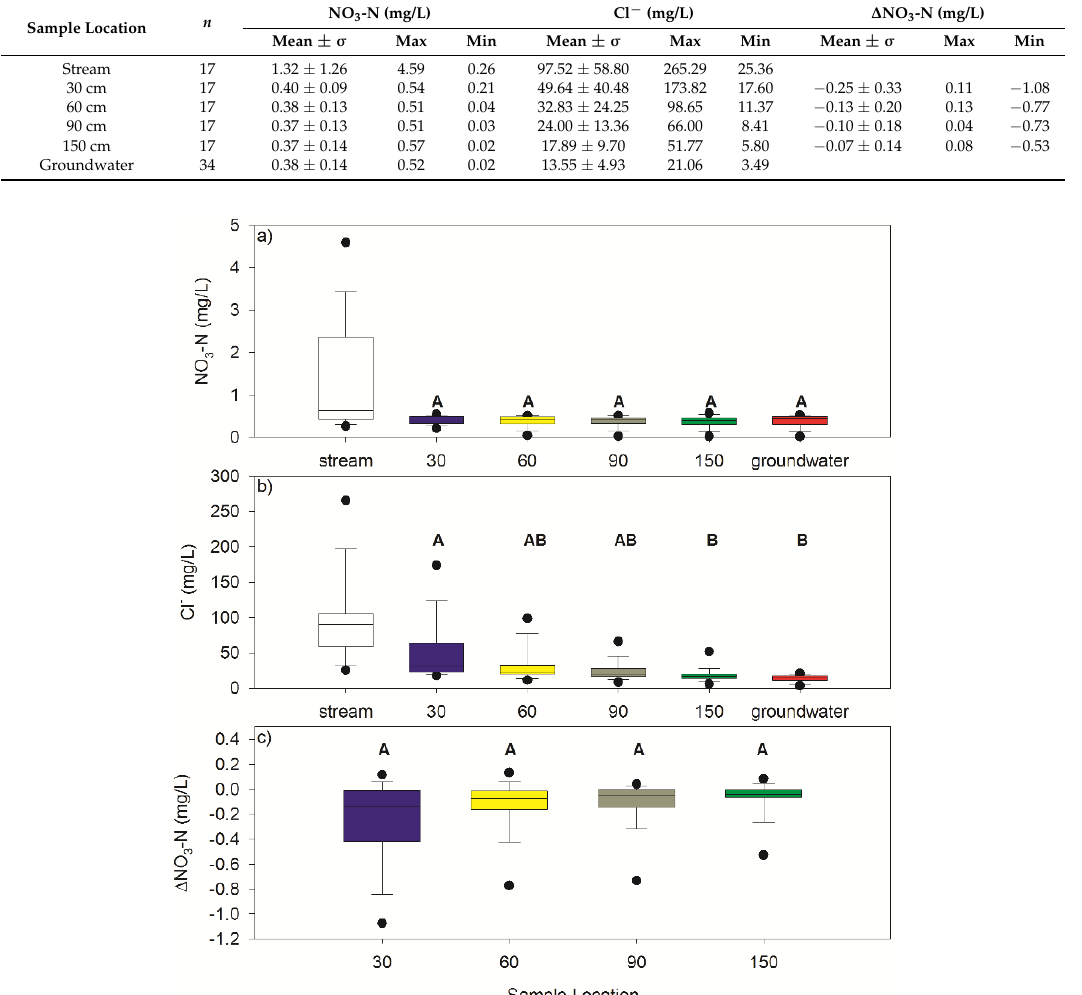
Figure 5. Box and whisker plots for ( a ) NO 3 -N concentrations, ( b ) Cl − concentrations, and ( c ) ∆ NO 3 -N values. Letters signify statistically similar means among the sample locations.